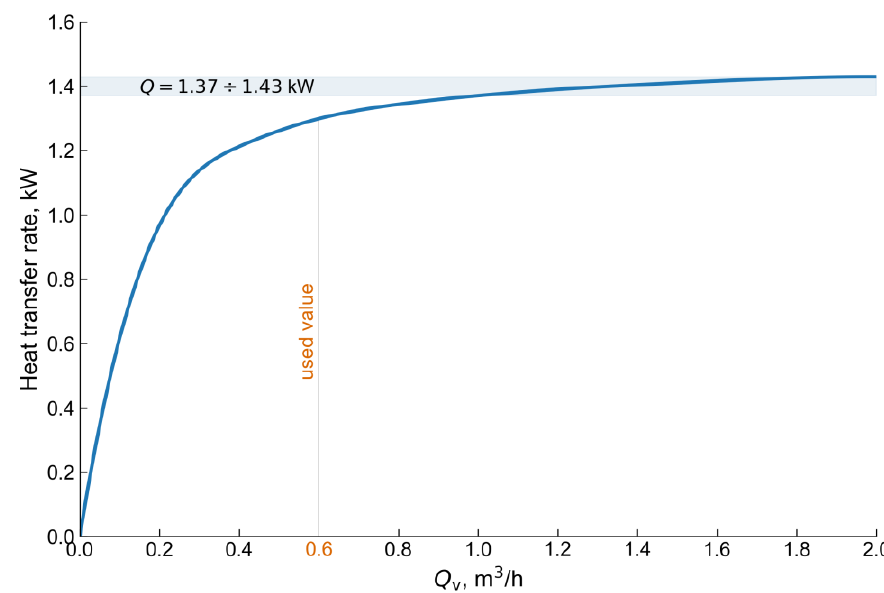
Figure 17. Dependence of the heat transfer rate on the HTF volumetric flow rate.